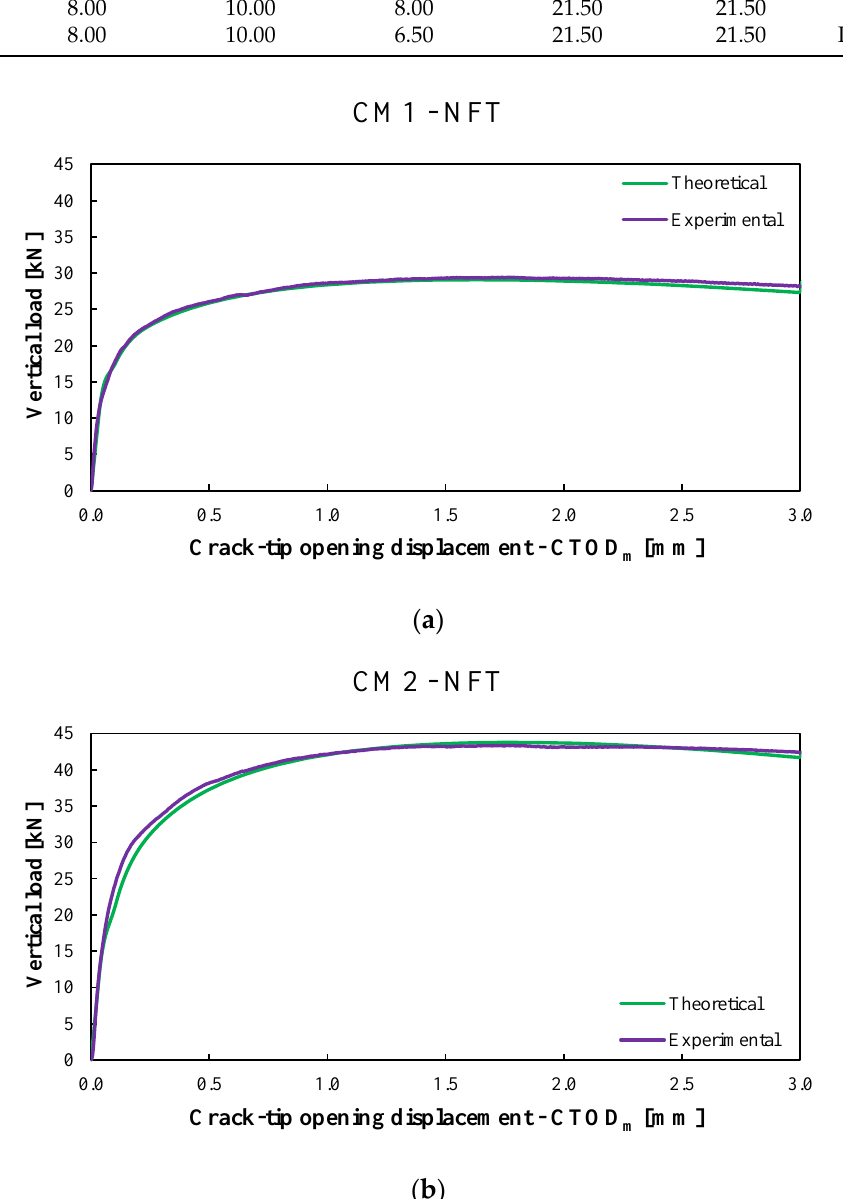
Figure 9. ( a ). The average experimental P − CTOD , avg curve (violet line) versus the average numerical P − CTOD , avg curve (green line) for unconditioned CM1 specimens (labelled CM1-NFT) obtained with the previous model of Ref. [42]. ( b ). The average experimental P − CTOD , avg curve (violet line) versus the average numerical P − CTOD , avg curve (green line) for unconditioned CM2 specimens (labelled CM2-NFT) obtained with the previous model of Ref.